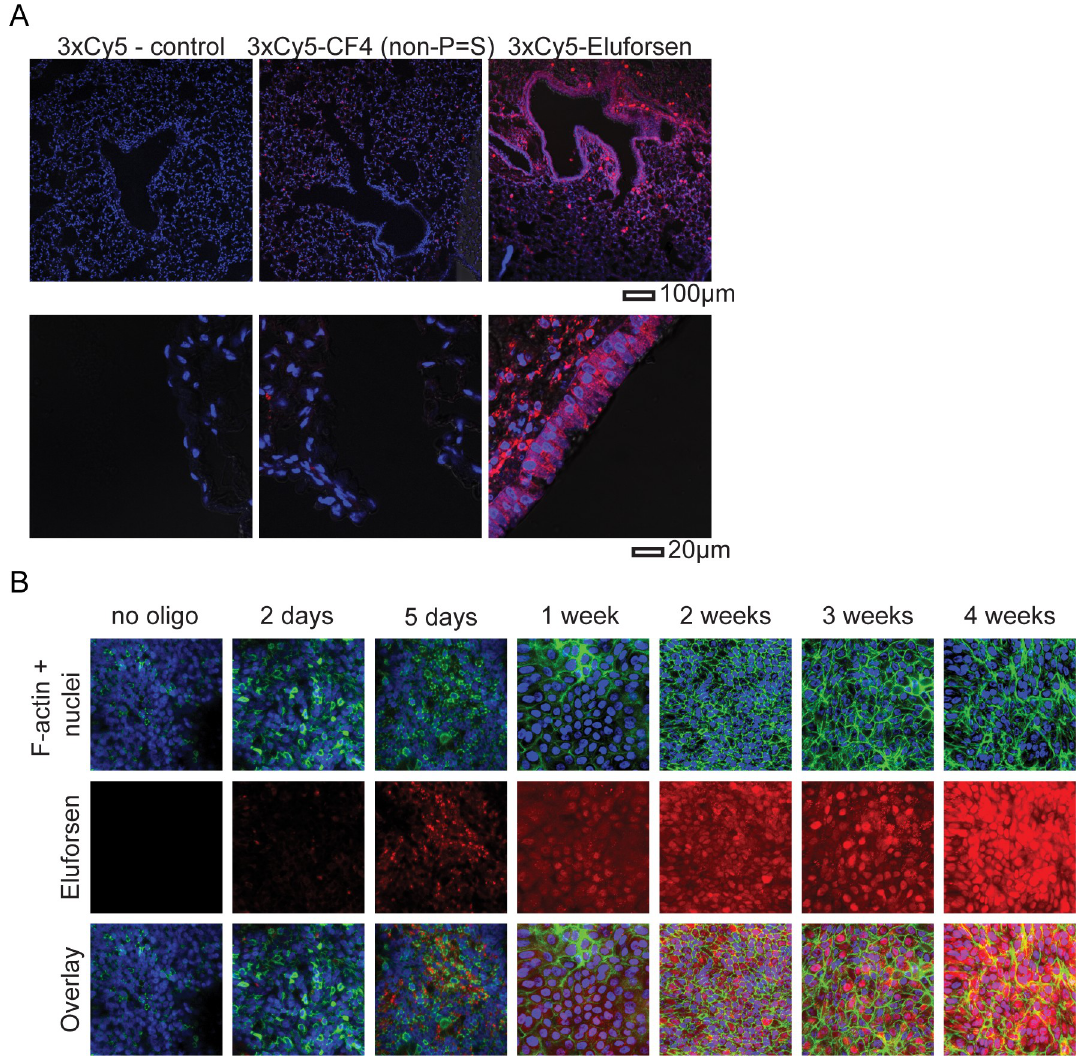
Fig 2. Cy5-labeled eluforsen is visualized in the airway epithelial layer after OT administration. (A) Representative confocal images of lung paraffin sections of wild-type mice that received daily OT administration of Cy5 (control), Cy5-labeled CF4, or Cy5-labeled eluforsen (10 mg/kg; equimolar dose) for 3 consecutive days and were killed on day 4. Nuclei were stained with DAPI (shown in blue). (B) Representative confocal images of HBE cultures treated with Cy5-labeled eluforsen (shown in red) stained for the nucleus (Hoechst, blue) and F-actin (Alexa Fluor 488-phalloidin, green).